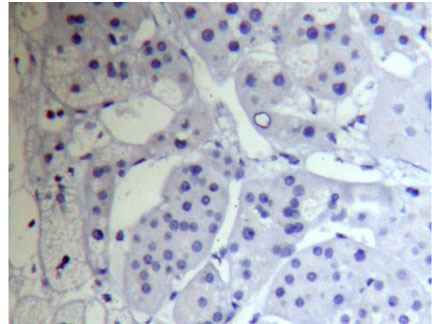
Adrenocortical carcinoma FHIT(−) SuperisionTM two footworks